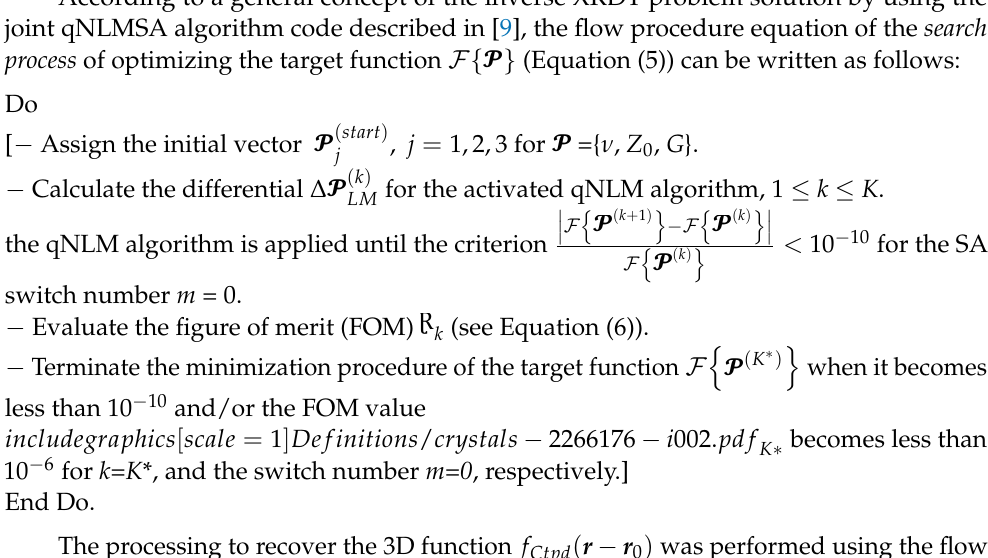
Figure 3. The 2D IPs: no- noise level (left), 4% -noise level (middle) and de-noised (right). The number of non-averaged IPs data frames is equal to 100. The sample rotation angles Φ are equal to {−20°, 0°, 20°}, respectively.